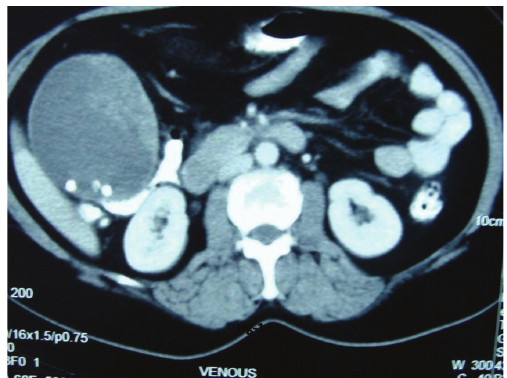
Figure 1: Biphasic CT abdomen showing gallbladder grossly distended: soft tissue mass in gallbladder with multiple intraluminal projections and features suggestive of cholelithasis with polypoidal gallbladder malignancy.